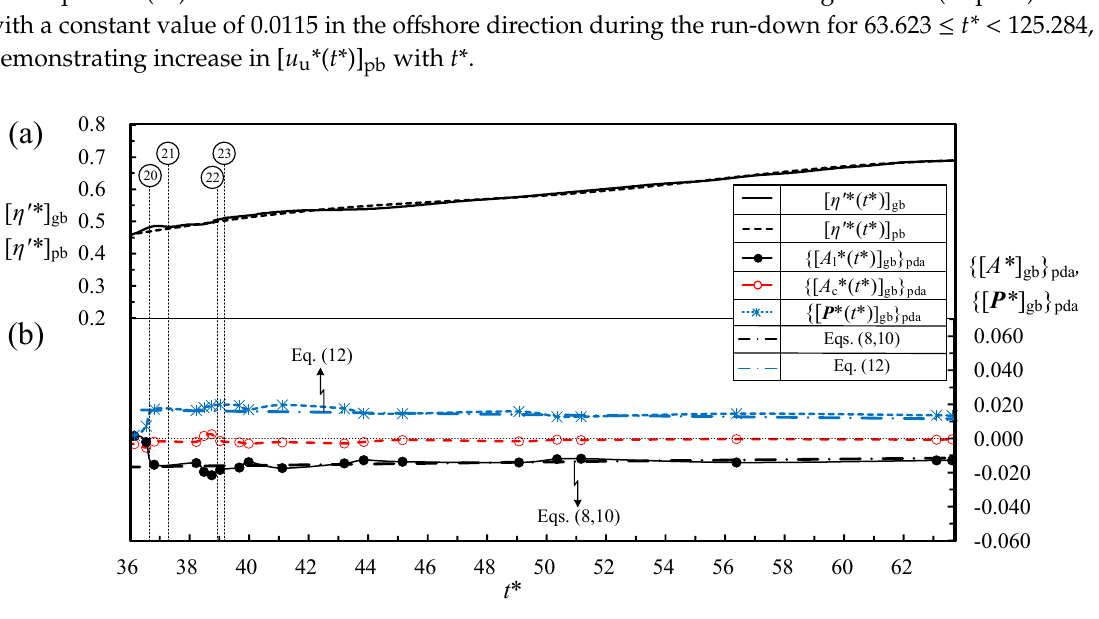
Figure 20. Variations of ( a ) [ η ′ *( t *)] gb and [ η ′ *( t *)] pb ; ( b ) {[ A l *( t *)] gb } pda , {[ A c *( t *)] gb } pda and {[ P *( t *)] gb } pda in onshore direction with t * for 36.0 ≤ t* ≤ 63.70 at SMS. Note that [ A l *( t *)] pb and [ P *( t *)] pb , are also included and vertical scale is 10 times smaller than that of Figure 19c. Times range from circled 20 to 23 are listed in sub-table of Figure 7a,b.